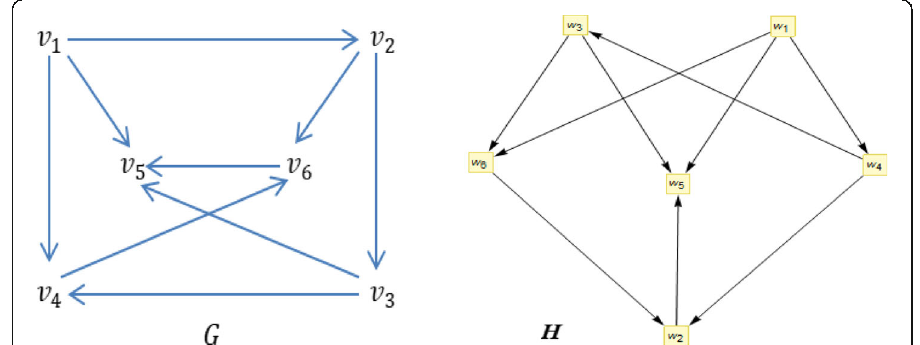
Fig. 1 Simple directed